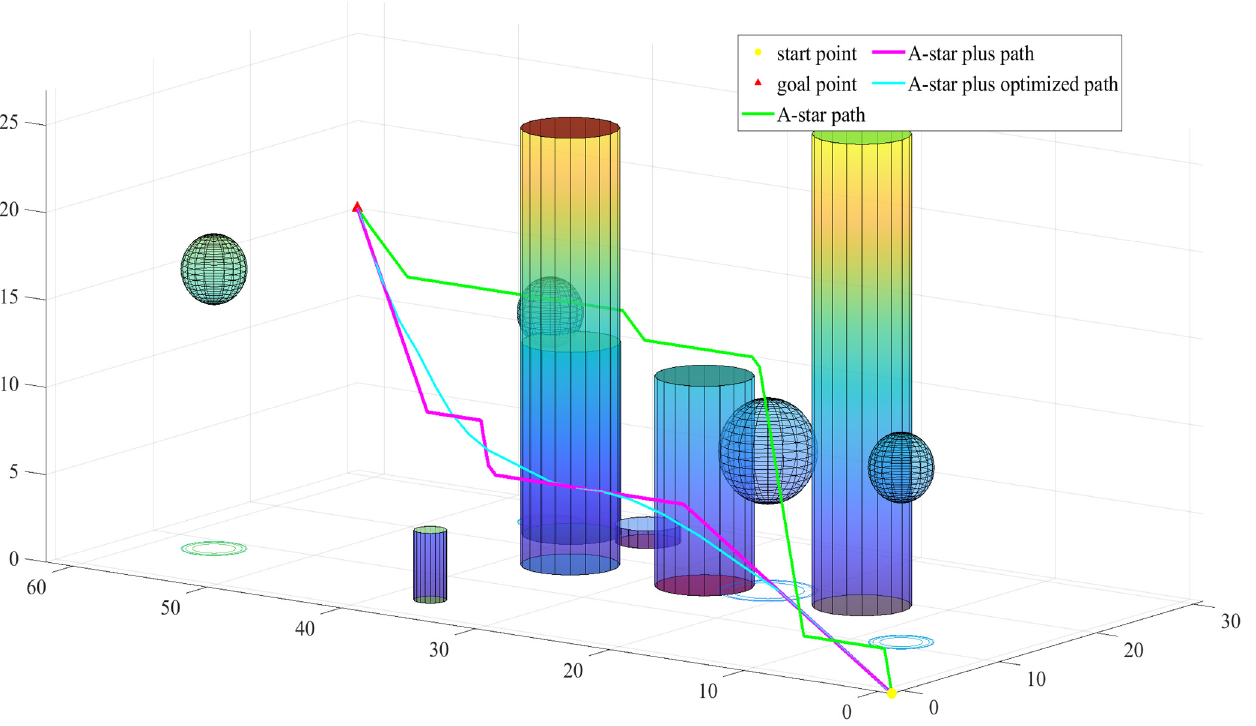
Figure 10. Comparison of A-star Plus algorithm and A-star algorithm.